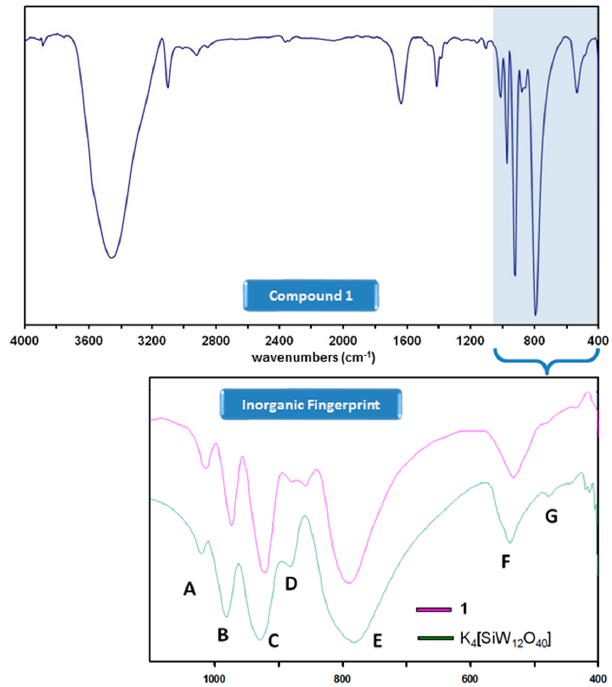
Figure 1. FT-IR spectrum of 1 and comparative detail of the inorganic fingerprint below 1000 cm − 1 with that of the K 4 [ α -SiW 12 O 40 ] precursor.